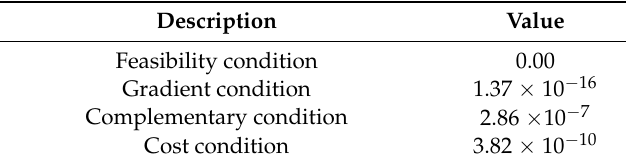
Table 1. Convergence criteria reached by the optimal solution: Test System